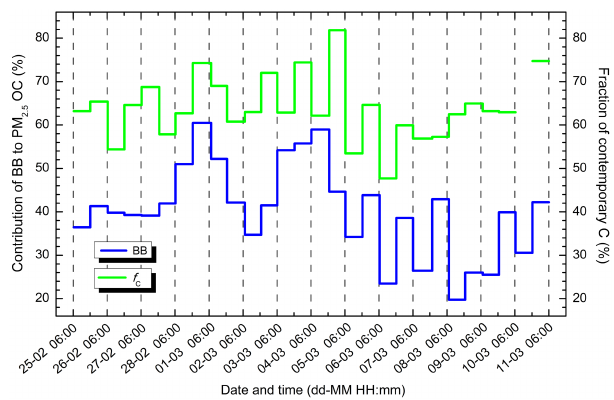
Figure 2. Temporal variability of the relative contribution of BB to the PM 2 . 5 -fraction OC assessed by the levoglucosan marker method, and of the fraction of contemporary carbon ( f C ) derived by the radiocarbon marker